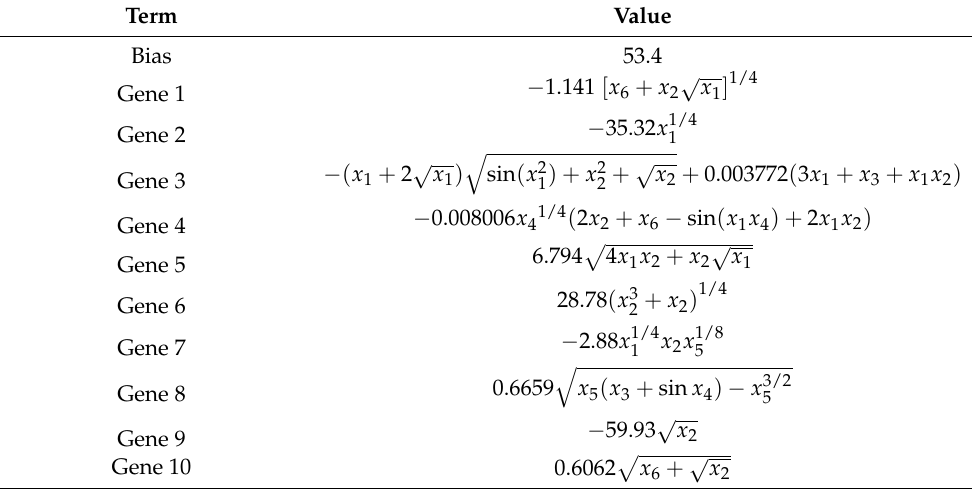
Table 4. Individual genes in the best MGGP